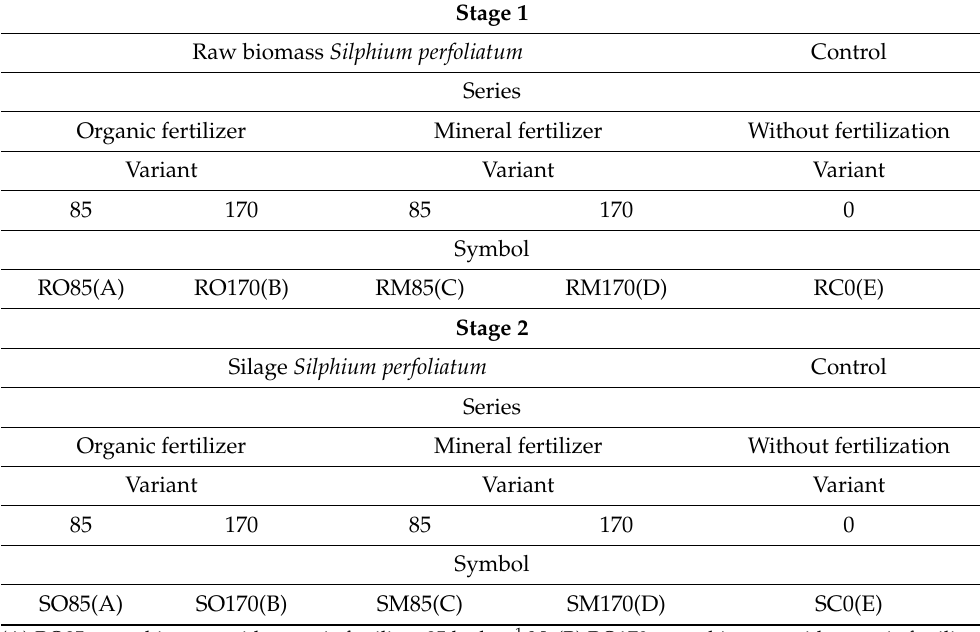
Table 1. The research design.